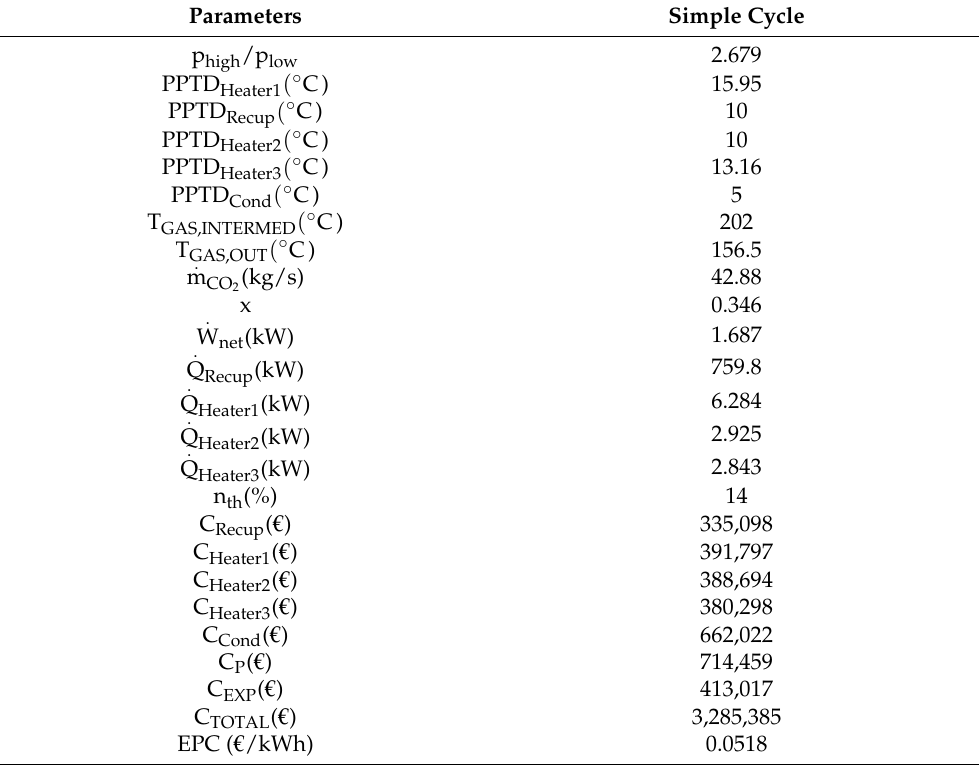
Table 8. Results from the optimization of the split cycle with the genetic algorithm. Parameters Simple